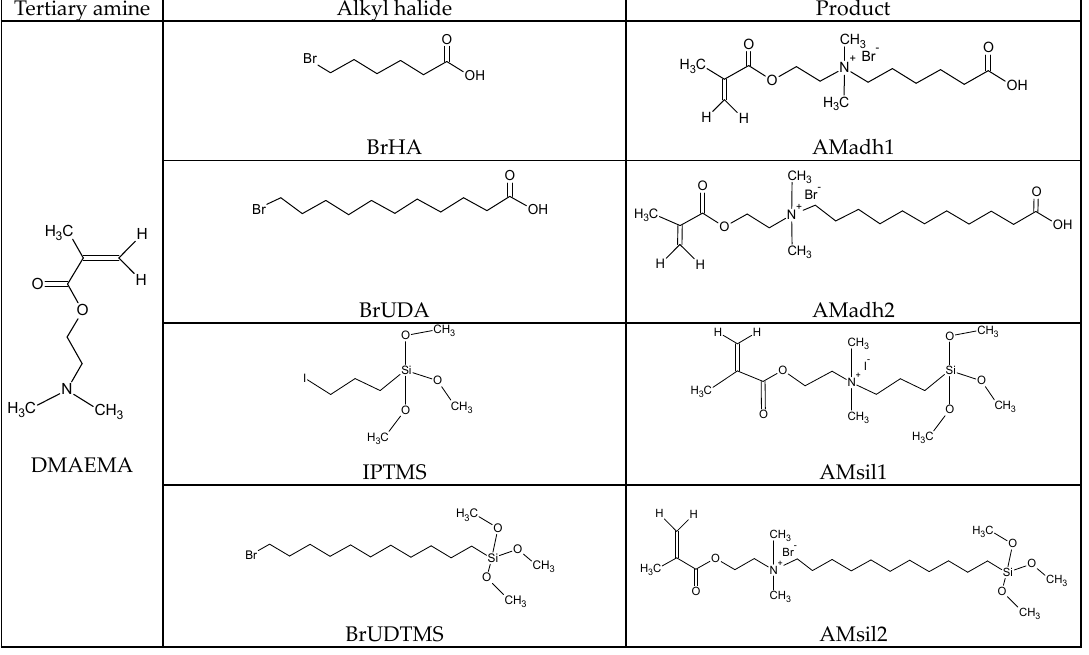
Figure 4. Reactants and corresponding quaternary ammonium monomer products.